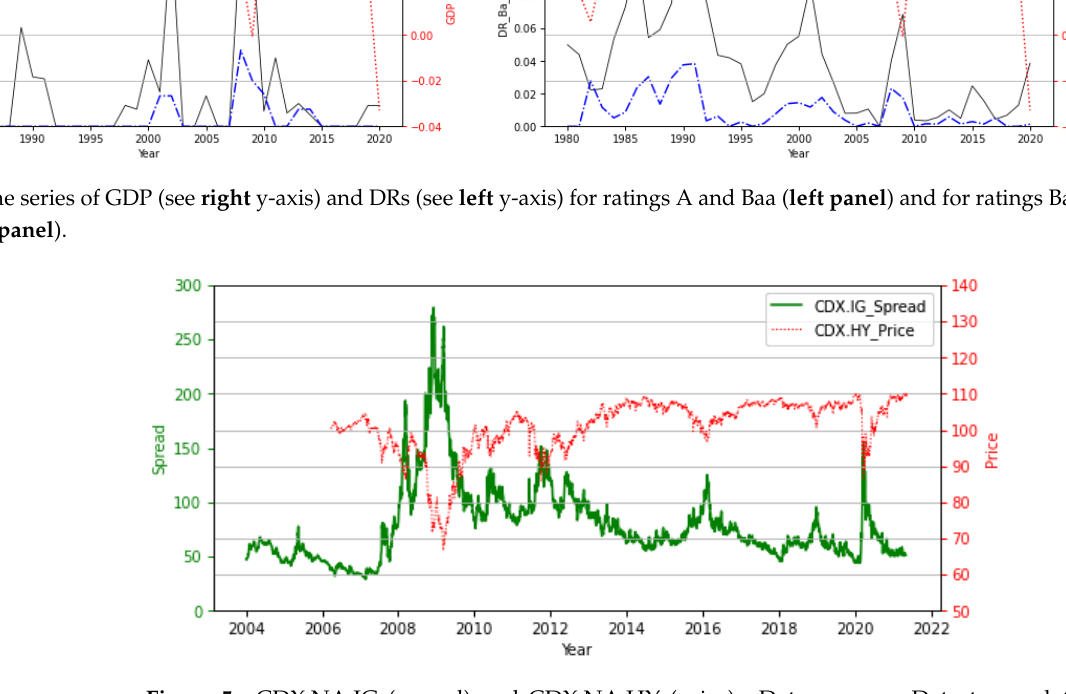
Figure 5. CDX.NA.IG (spread) and CDX.NA.HY (price). Data sources: Datastream database and Bloomberg.